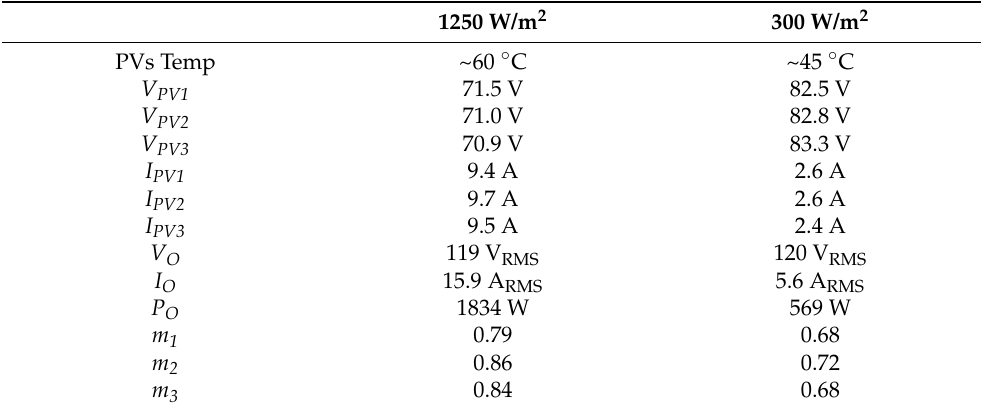
Figure 9. ( a ) Inverter output voltage and current injected to the grid for the high irradiation; ( b ) low irradiation; ( c ) Harmonic spectrum for the inverter output voltage for the high irradiation; ( d ) low irradiation; ( e ) Harmonic spectrum for the inverter output current for the high irradiation; ( f ) low irradiation. Table 3. Comparison between steady-state parameters for high and low irradiance.